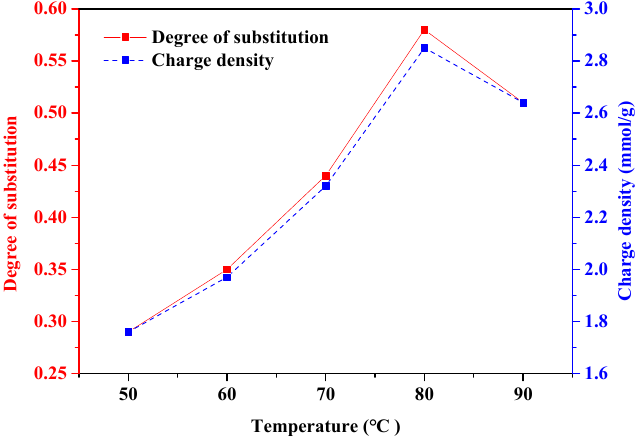
Figure 4. The effect of temperature on the degree of substitution and charge density of phosphorylated xylan (conducted at the xylan/STMP molar ratio of 1/3 for 3 h).